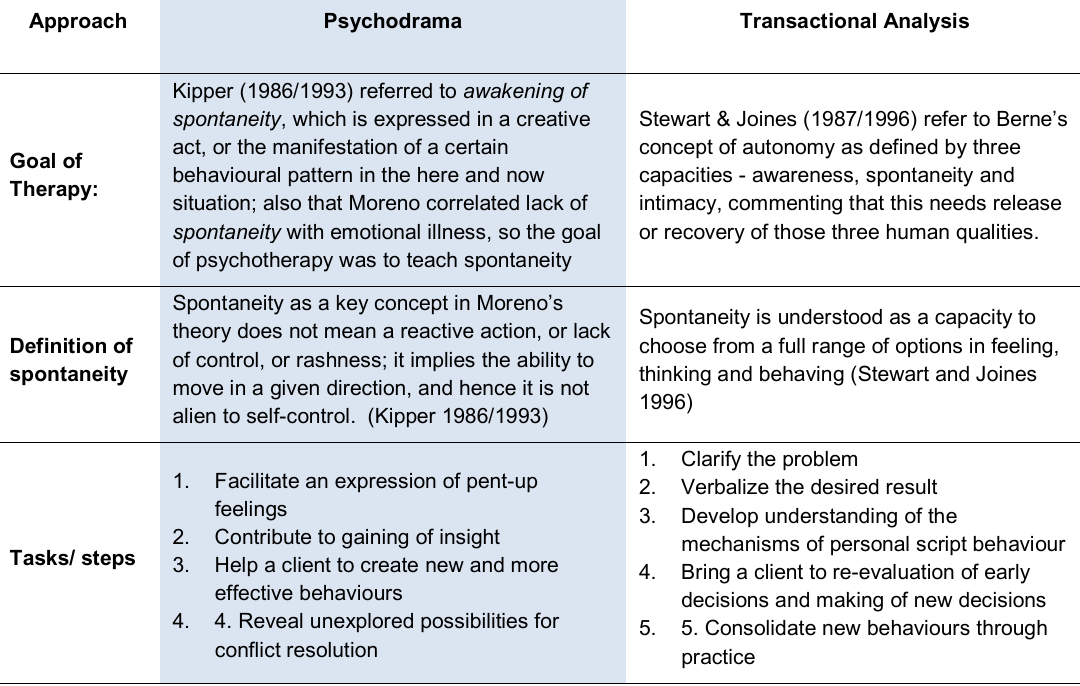
Comparison of the Methods in Psychodrama and